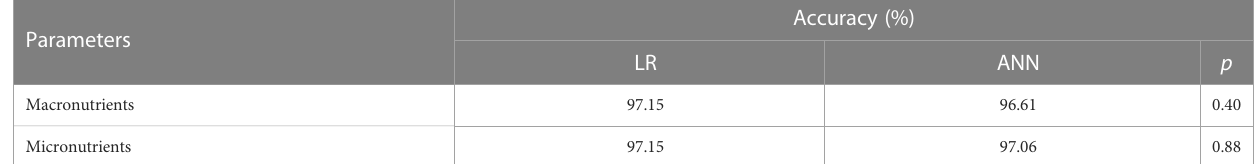
TABLE 4 Accuracy table based on the confusion matrix of LR and ANN to predict gastrointestinal cancer, in macro- and micronutrients.